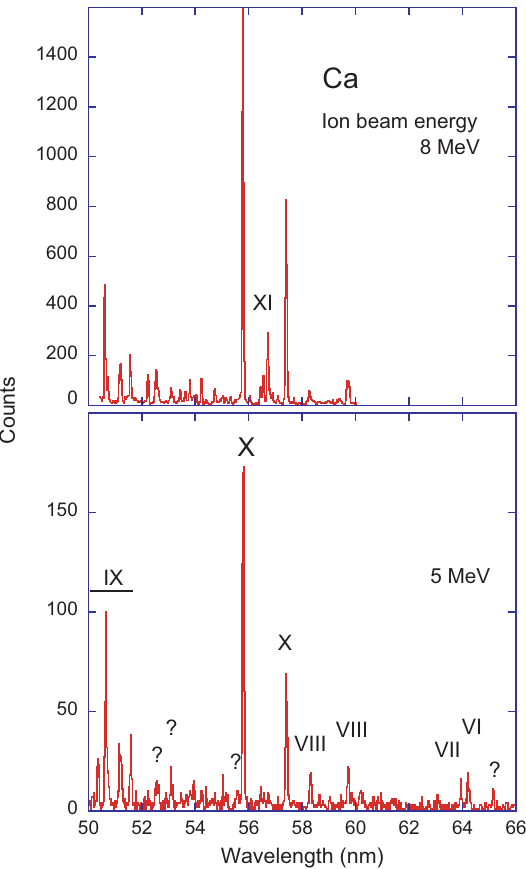
Figure 3. Ca beam-foil spectra obtained at ion beam energies of 5 and 8MeV, respectively. Line width